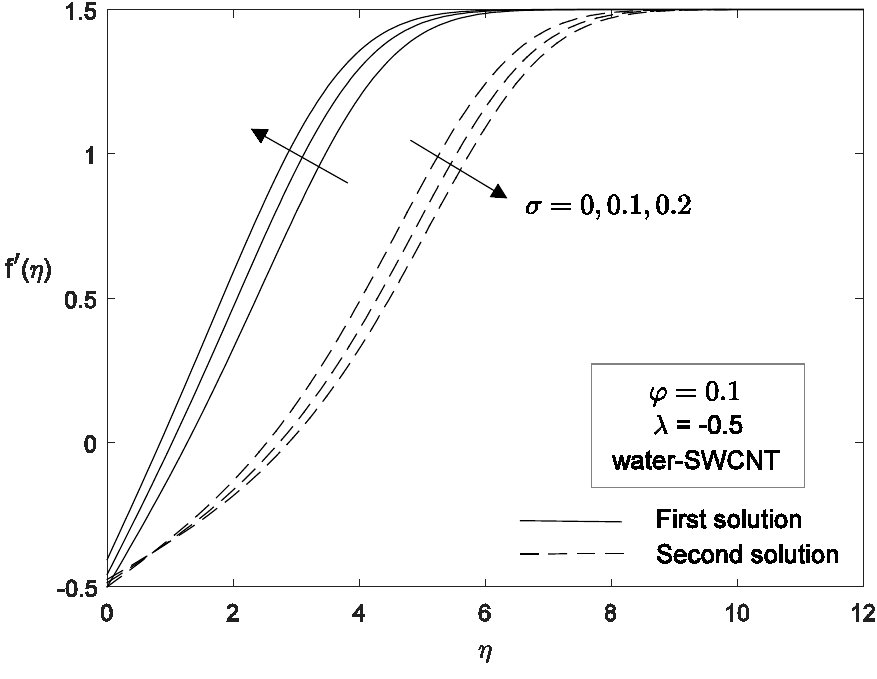
Figure 20. Effect of various σ on velocity profile.